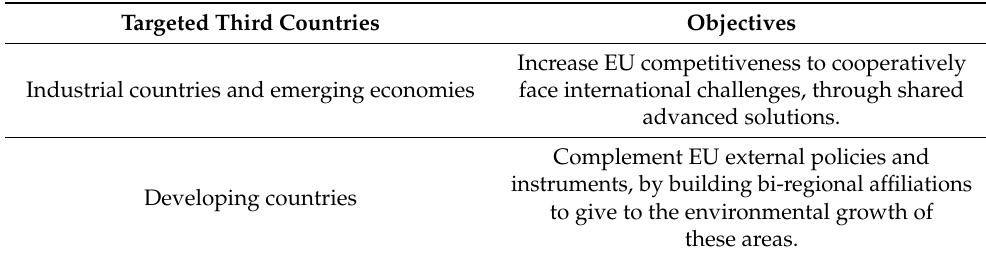
Table 1. EU purposes in scientific collaboration with targeted third countries. Targeted Third